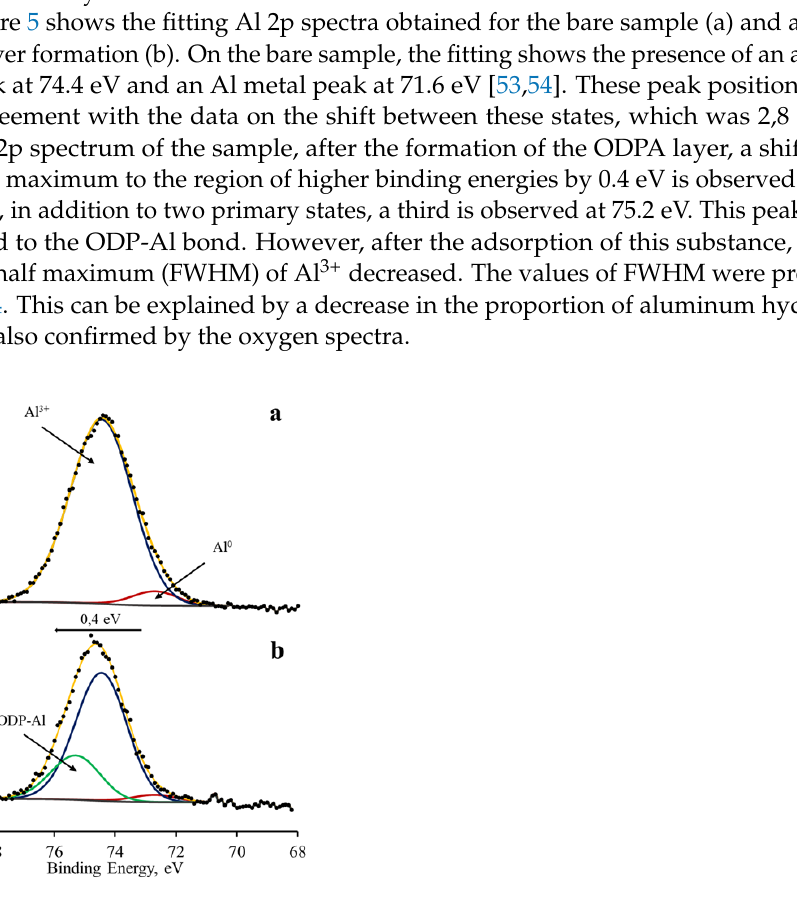
Figure 5. Al2p core level XPS spectra of the bare sample ( a ) and after the ODPA layer formation ( b ). Table 4. Values of FWHM for the bare sample (1) and after the ODPA layer formation (2). States